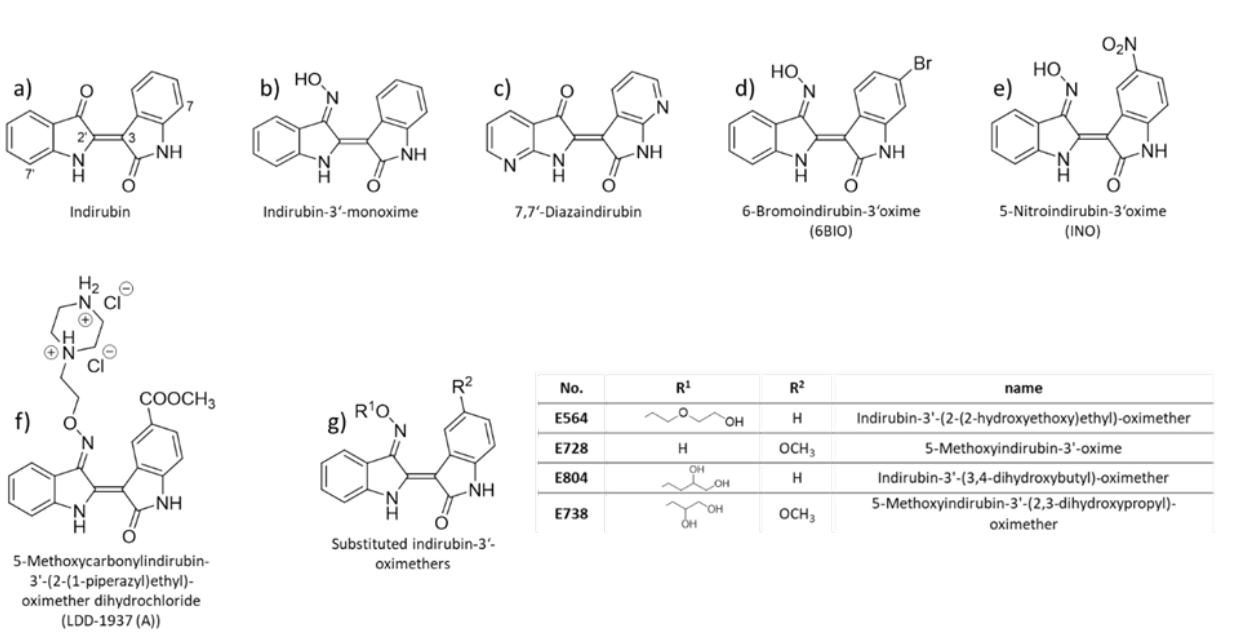
Figure 1. Indirubine and its derivates. ( a ) Indirubin; ( b ) Indirubin-3 (cid:48) -monoxime; ( c ) 7,7 (cid:48) -Diazaindirubin; ( d ) 6-Bromoindirbun-3 (cid:48) -oxime (6BIO); ( e ) 5-Nitroindirubin-3 (cid:48) oxime (INO); ( f ) 5-Methoxycarbonylindirubin-3’-(2-(1-piperazyl)ethyl)-oximether dihydrochloride (LDD-1937 (A)); ( g ) substituted indirubin-3 (cid:48) -oximethers: Indirubin-3 (cid:48) -(2-(2-hydroxyethoxy)ethyl)-oximether (E564), 5-Methoxyindirubin-3 (cid:48) -oxime (E728), Indirubin-3 (cid:48) -(3,4-dihydroxybutyl)-oximether (E804), 5-Methoxyindirubin-3 (cid:48) -(2,3-dihydroxypropyl)-oximether (E738).